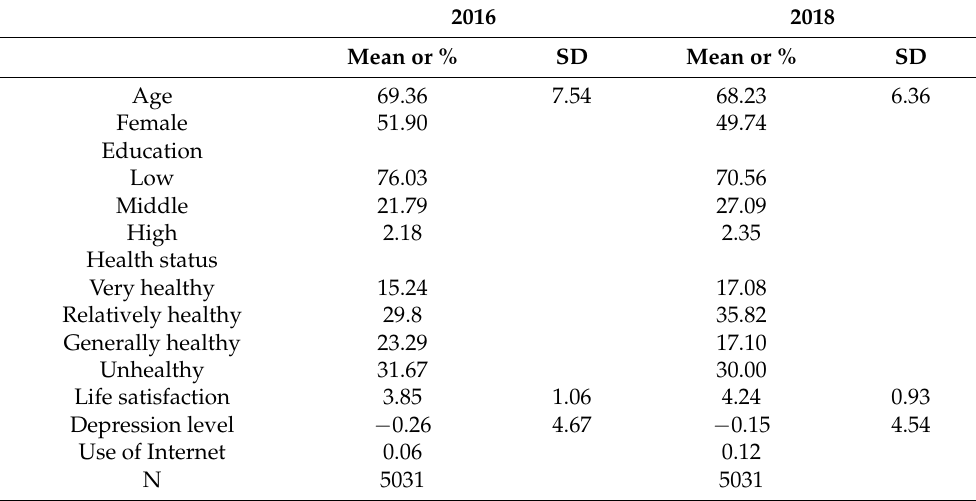
Table 1. Characters of study